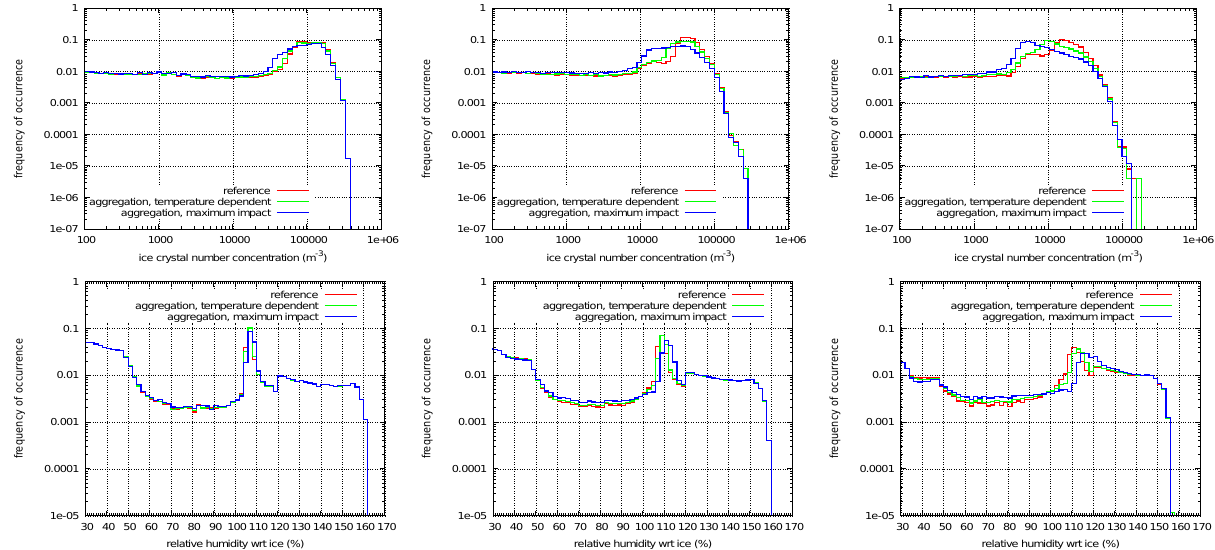
Fig. 10. Vertical profiles of mean ice crystal number concentration (left), ice water content (middle) and relative humidity wrt ice (right) at the end of the simulation ( t = 240 min, w = 5cm s − 1 ) for different temperature regimes. Top row: low temperature conditions, middle row: medium temperature conditions, bottom row: high temperature conditions